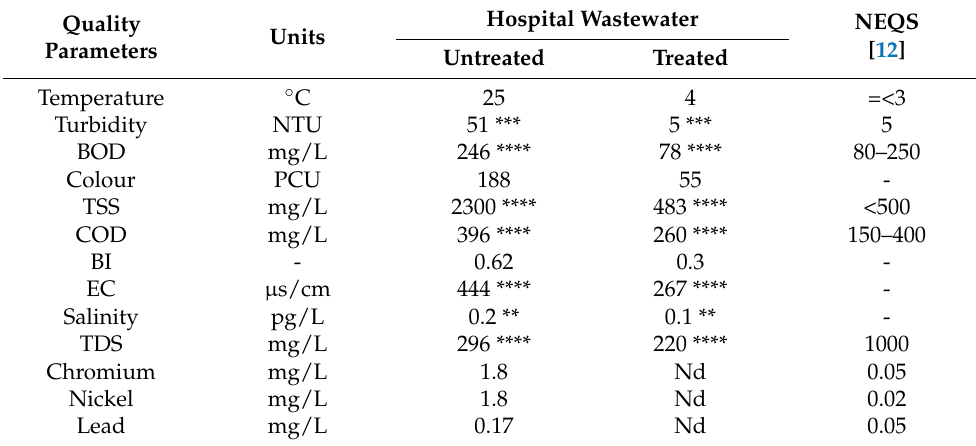
Table 1. Hospital Wastewater Quality